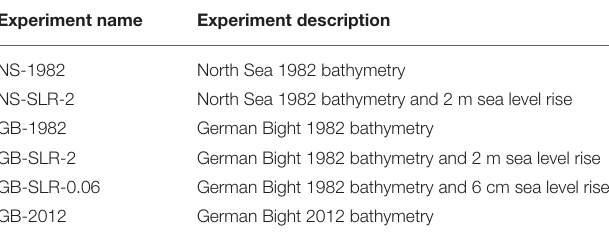
TABLE 2 | Nomenclature of barotropic experiments analyzing the effects of